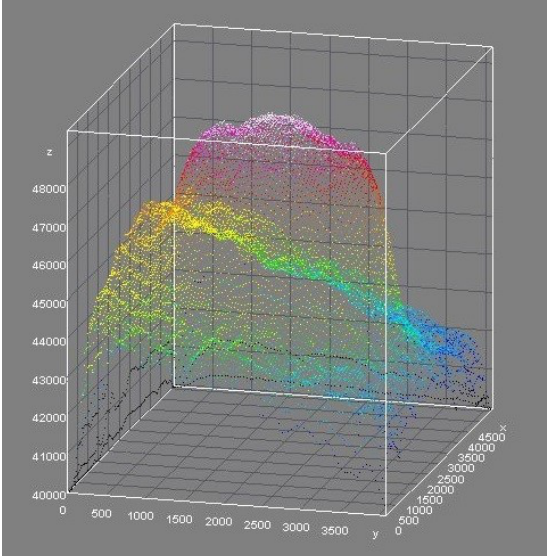
Figure 10. 3D neutrogram of neutron